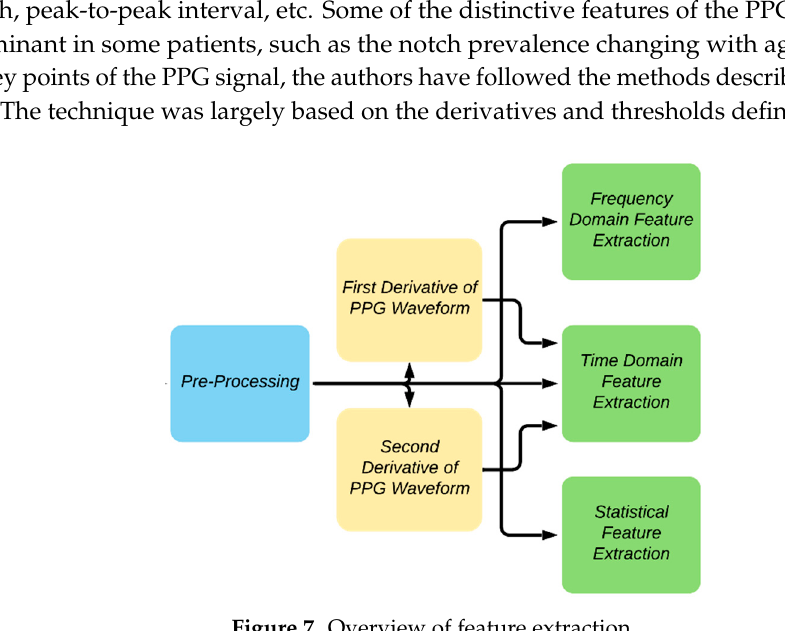
Figure 7. Overview of feature extraction.